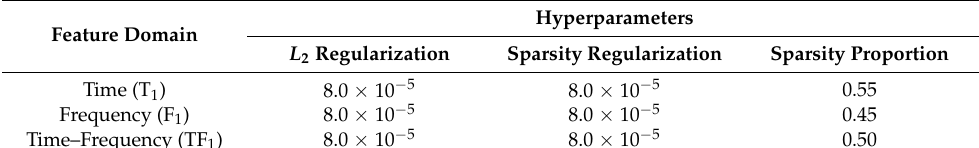
Table 9. Hyperparameter used in a deep SAE-based model for vibration signals in CWRU database.